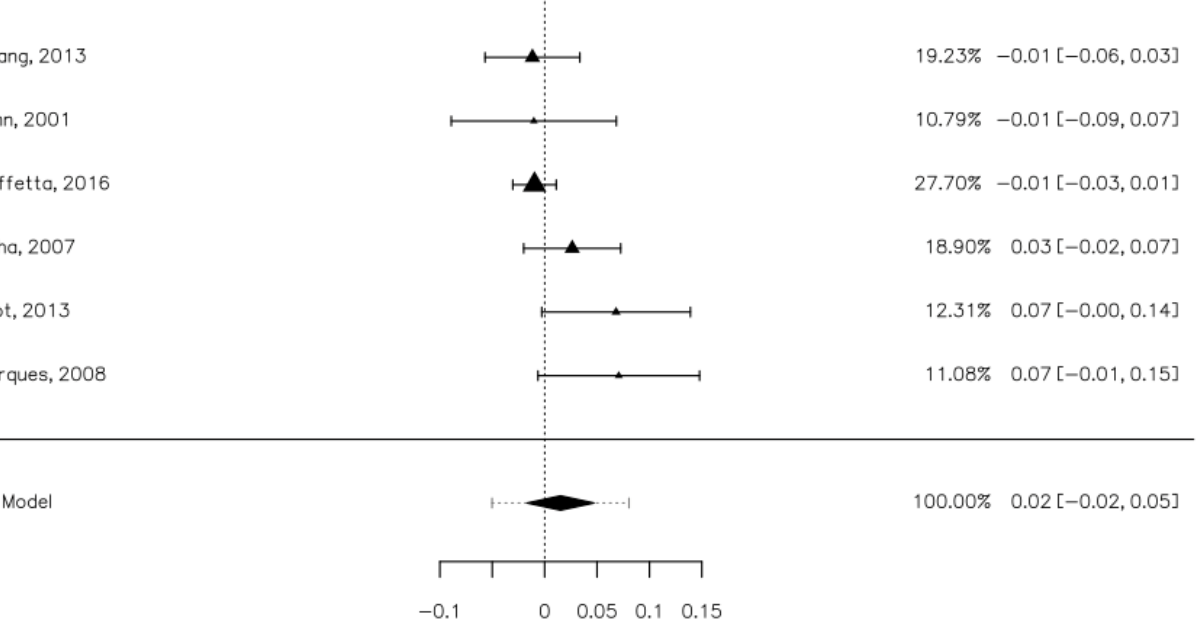
Figure 4. Forrest plot. The risk of oral cancer associated with mouthwash use.